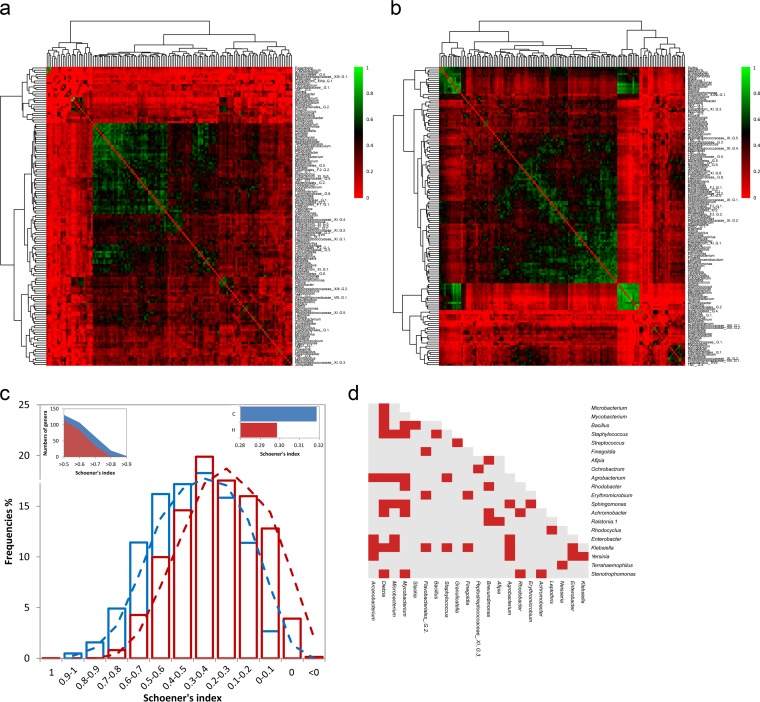
Heatmaps displaying genus distribution patterns for the healthy (a) and caries (b) groups. Increasing values are translated into colors from red to green. Trees were clustered based on the similarity of the Schoener's values. (c) The cooccurrence probabilities based on the Schoener's index were divided into 13 intervals, including <0, 0, 0 to 0.1, 0.1 to 0.2, 0.2 to 0.3, 0.3 to 0.4, 0.4 to 0.5, 0.5 to 0.6, 0.6 to 0.7, 0.7 to 0.8, 0.8 to 0.9, 0.9 to 1, and 1. The frequency of the Schoener's index falling into each interval was calculated in both the caries group and the healthy group. The number of involved genera at the different intervals and a global comparison of the Schoener's index between the two groups (using a t test) are also shown within the plot. (d) All pairs with Schoener's index greater than 0.8.